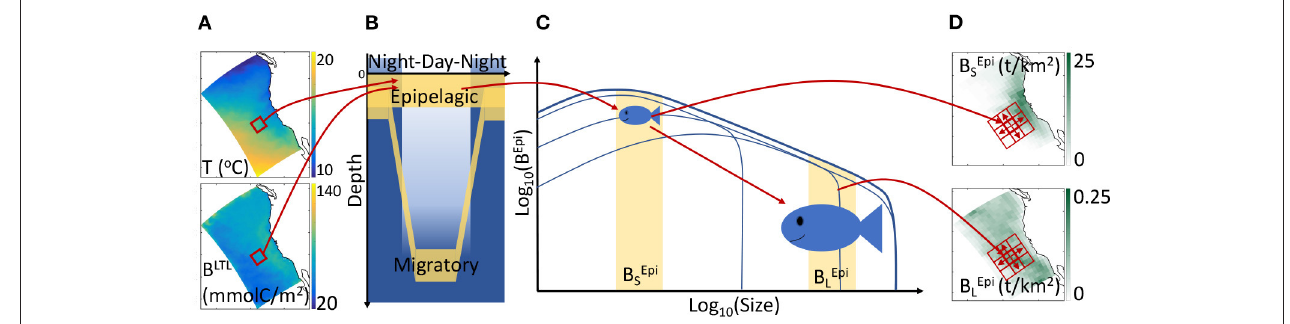
FIGURE 1 | Schematic of APECOSM. (A) Illustration of the 3D environmental forcing from simulations with the physical-biogeochemical model ROMS-BEC, including temperature T and biomass of lower trophic levels ( B LTL ). (B) The 3D environmental forcing defines the habitat of distinct epipelagic and migratory communities. (C) Environmental conditions influence individual metabolism at different sizes, modulating growth, feeding, reproduction, and mortality, thus driving the temporal evolution of the biomass density size-spectrum, here shown for epipelagic fish ( B Epi ). (D) The integrated biomass of different size ranges determines the spatial biomass distribution, here shown for small ( B Epi S ) and large ( B Epi L ) fish. Neighboring cells (red squares) exchange biomass by passive transport and active